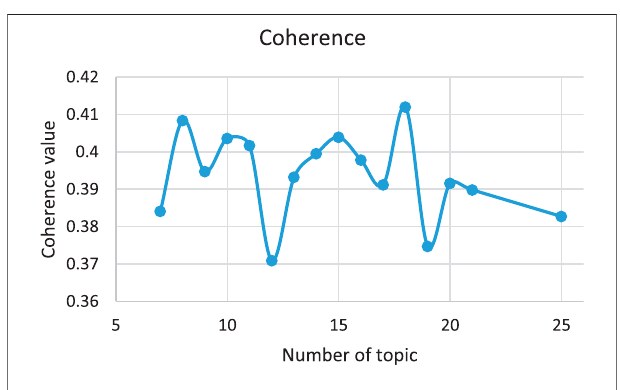
FIGURE 7 | Coherence of topics of topic model analysis of Corona forum.